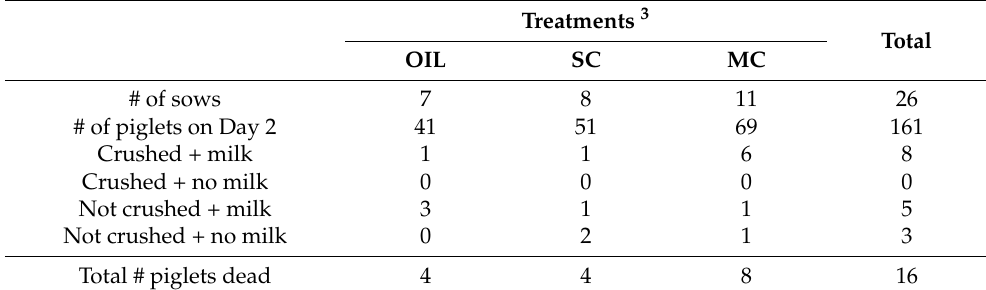
Table 1. Descriptive results of number (#) of piglets that died on Day 2 to 5, when the enrichment ropes were present in the farrowing stall. All piglets were necropsied to identify those that were crushed 1 and to check for milk presence in the stomach 2 .